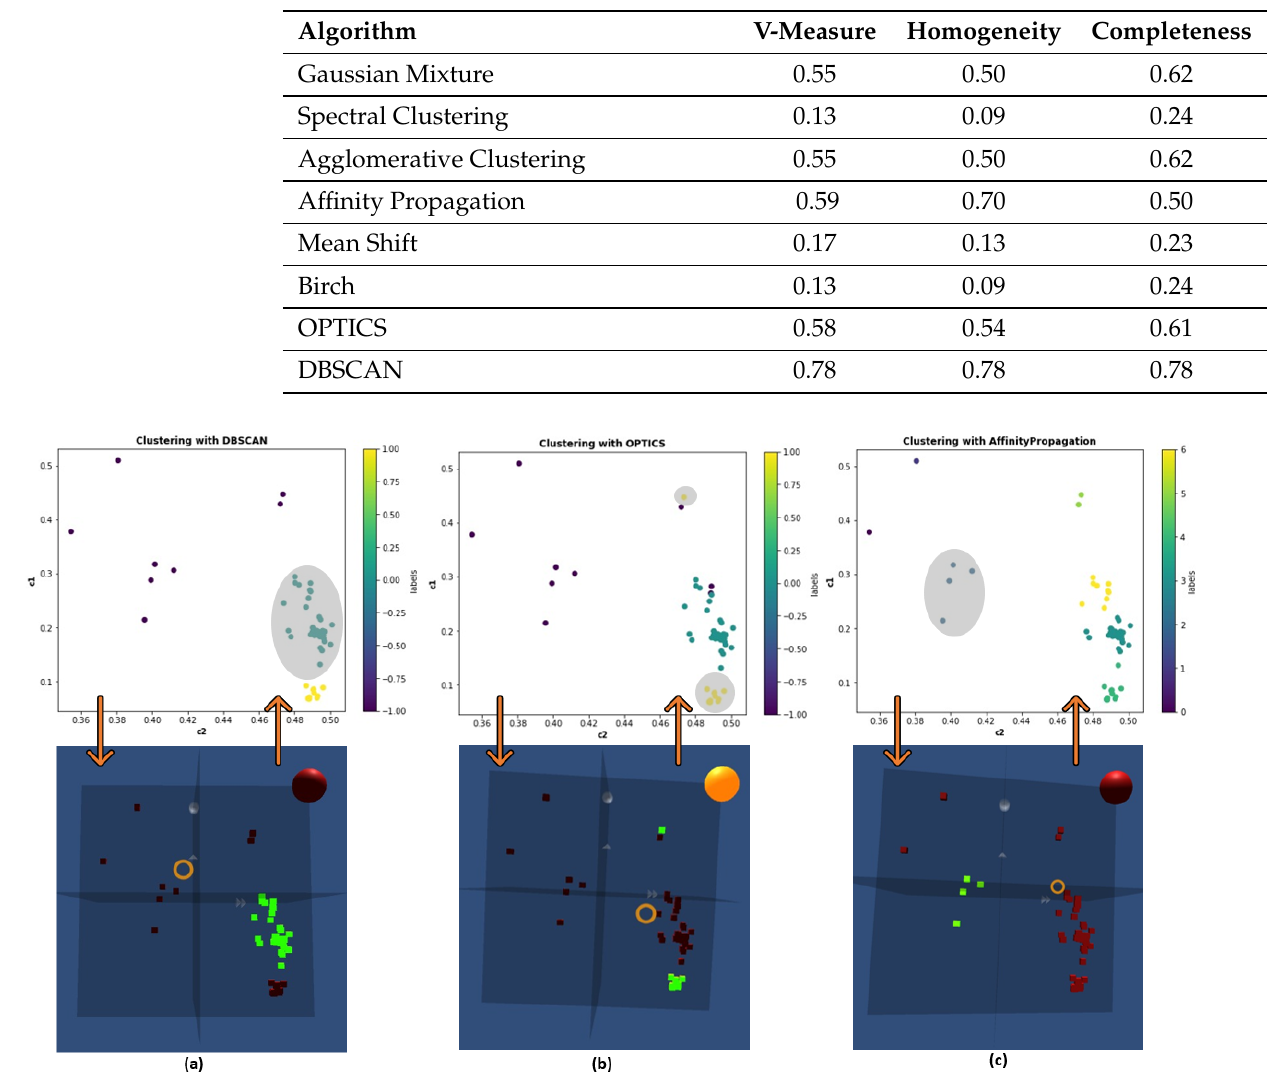
Table 1. Comparison of clustering algorithm on sample dataset with known cluster labels assignment. The higher the value, the better. The comparison was done over the DS1 as it contained the data labeling required by the used metrics.